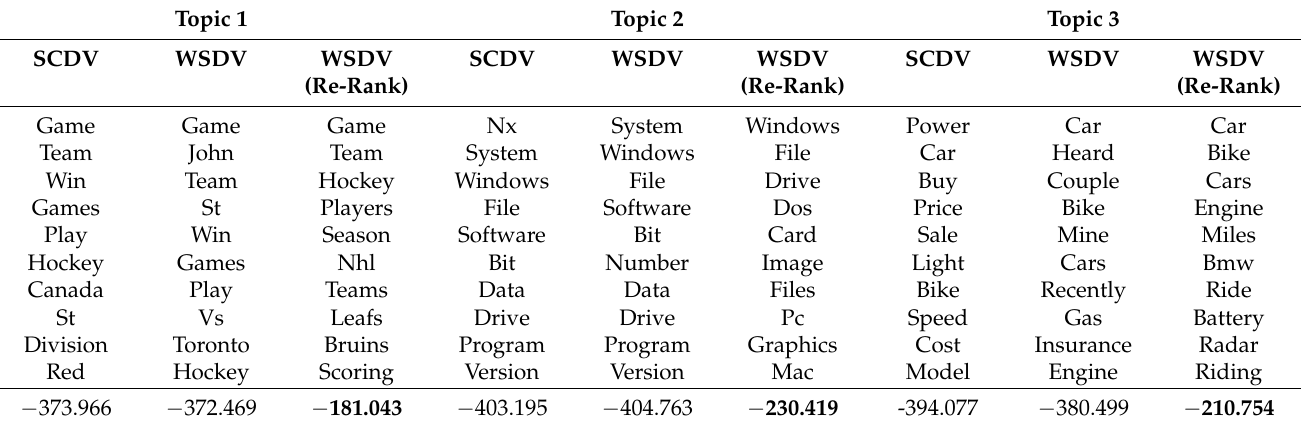
Table 6. Top words and Coherence scores of few topics using 20newsgroup dataset (20